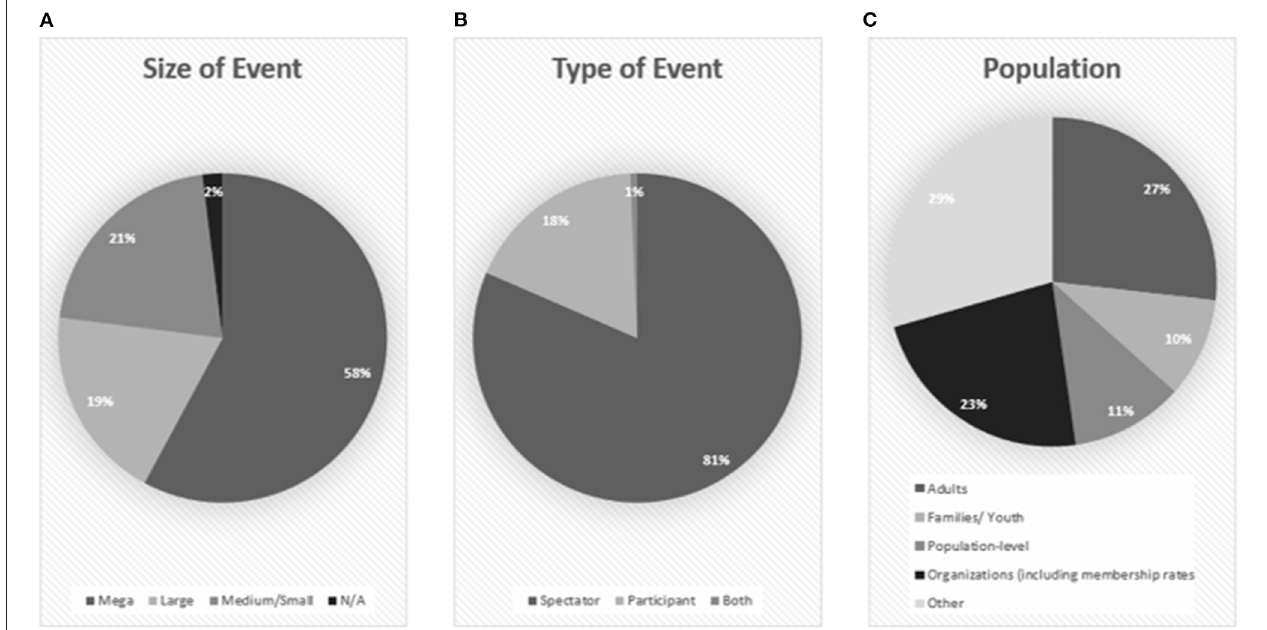
FIGURE 3 | Study context: Size of event (A) , Type of event (B) , and Study population (C)